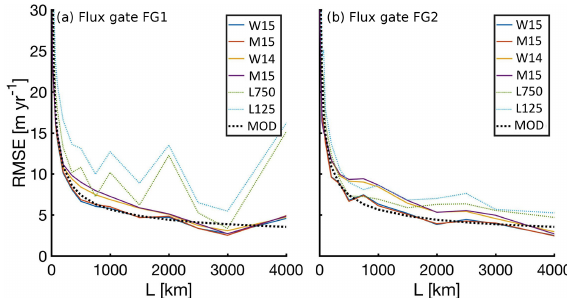
Figure A1. RMSE of the Landsat component of velocity that is normal to the flux-gate cross section at FG1 (a) and FG2 (b) flux nodes relative to ∼ 2008 SAR velocities (Rignot et al., 2011a) as a function of averaging distance ( L ). MOD is the modeled uncertainty assuming a fully correlated uncertainty of 1myr − 1 plus a 3myr − 1 uncertainty that is uncorrelated at distances greater than